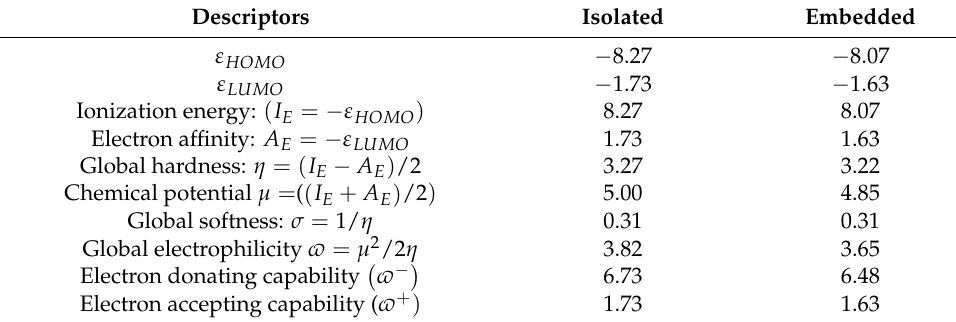
Figure 6. Plot of the HOMO and LUMO frontiers orbitals and the gap energies for the QBCP isolated ( a ) and embedded ( b ) molecules. Table 6. The global reactivity descriptors. Energies are in eV